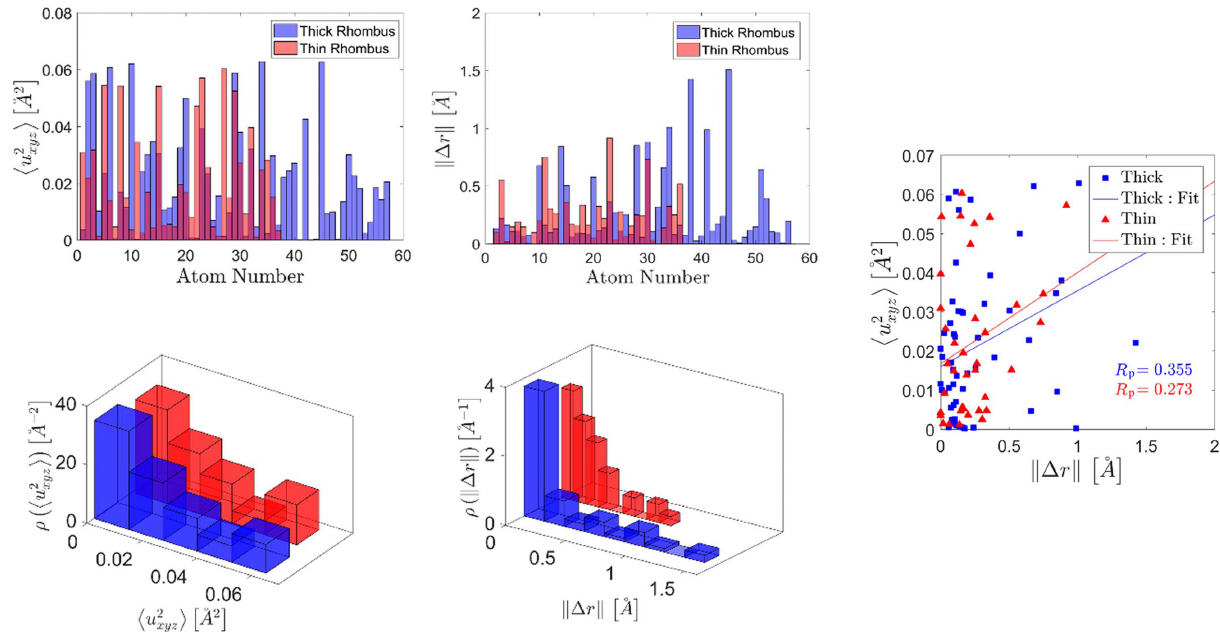
Figure 11 Mean displacement parameter and atomic shift after the refinement for each atom in the asymmetric part of the model. The distribution of the parameters is plotted below with red assigned to the thin rhombus and blue for the thick rhombus. The correlation between the magnitude of the atomic shift jj (cid:4) r jj and the phononic mean displacement parmeter u 2 is presented. For both units a weak positive correlation is xyz